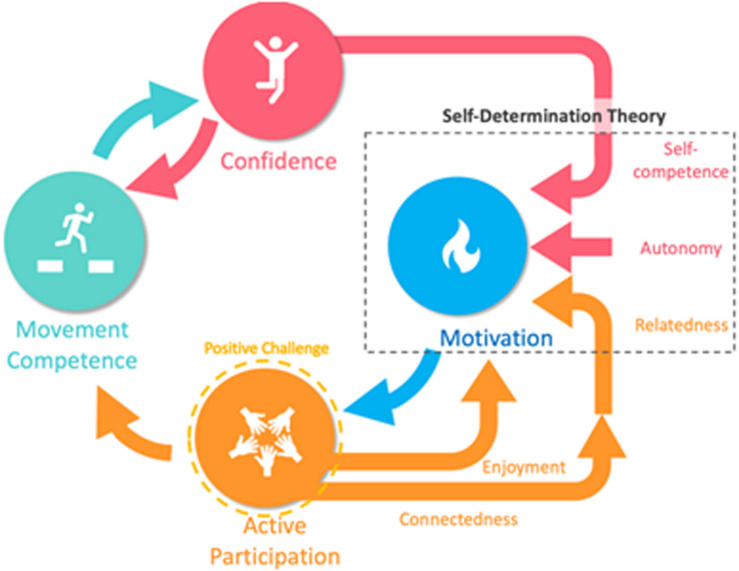
Physical literacy cycle adapted from Cairney et al., 2019 and Jefferies et al., 2019 with self-determination theory integrated.